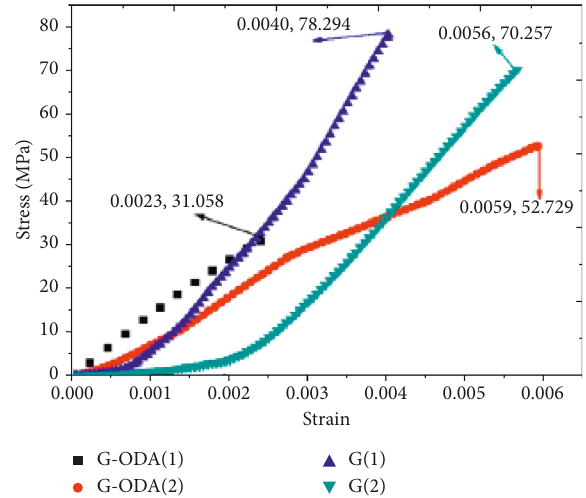
Figure 2: Stress-strain curves for the strip GP and G-ODA